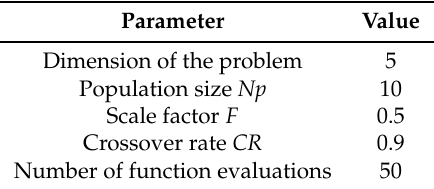
Table 3. Used parameter values for the DE optimization